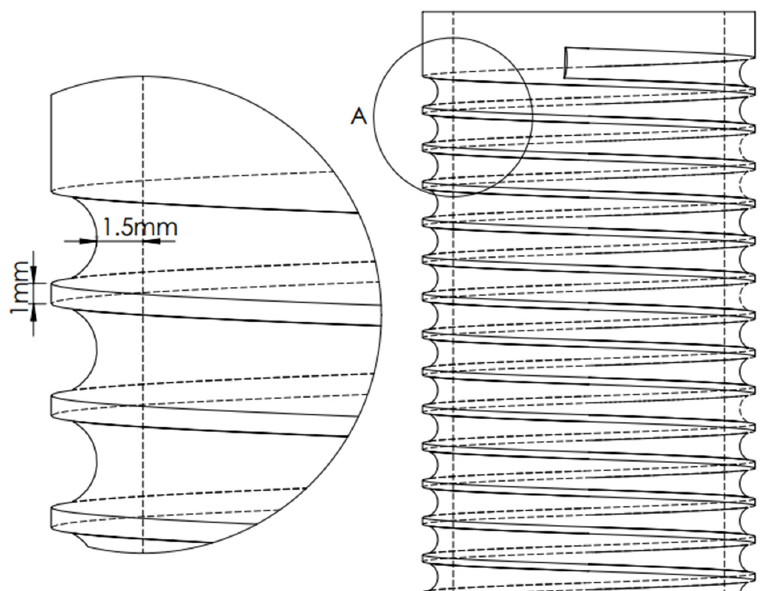
Figure 2. A view of the internal structure of the aluminum threaded core. The figure on the right is a magni fi cation of the “A” region.